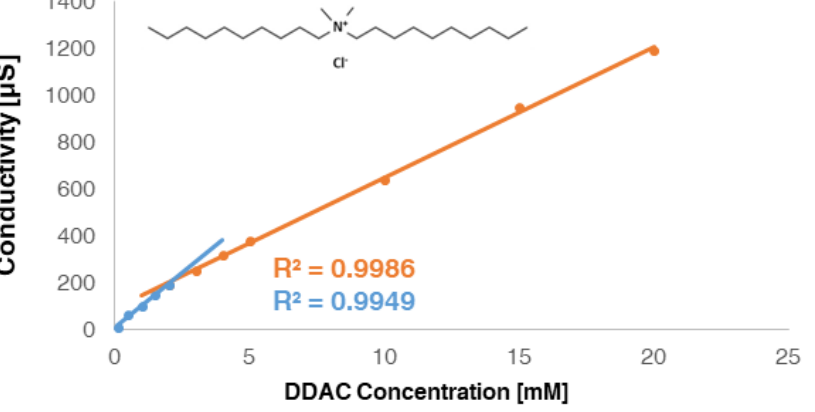
Figure 1. The electric conductivity of DDAC solution concentration, showing linear fits below (blue) and above (orange) the inflexion extrapolated point, which is the CMC.